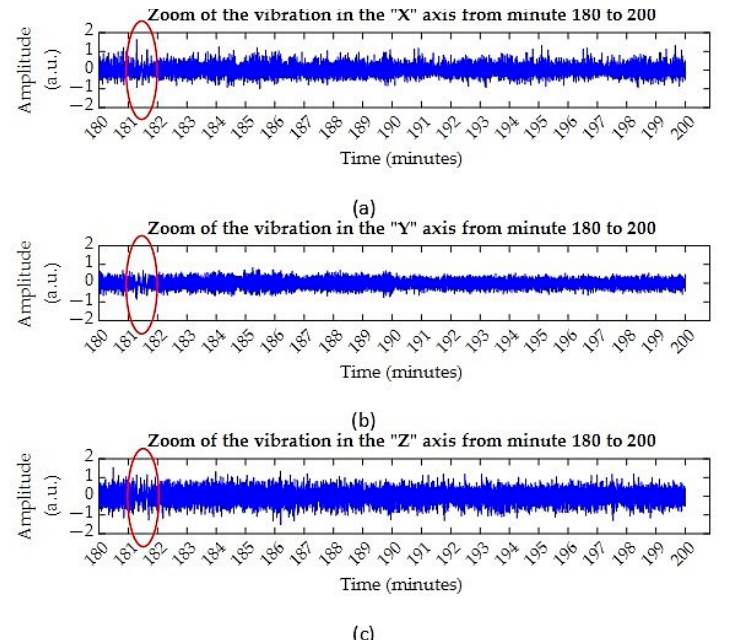
Figure 7. A disturbance in the system is shown zooming in from 180 to 200 min according to the axis: ( a ) “X” axis; ( b ) “Y” axis; ( c ) “Z” axis; a.u (arbitrary units). Figure 8 shows a zoom from minute 181.25 to 181.5, demonstrating the balance men- tioned at minute 181.27, where the “X” axis is the one that receives the highest positive amplitude, giving a peak of 1.645 a.u. (Figure 8a) while the “Y” axis has a negative peak of − 0.860 a.u. (Figure 8b), and the Z axis does not reach a maximum peak, but shows a positive amplitude, reaching 0.391 a.u. (Figure 8c). In Figure 8b, the “Z” axis does not reach a maximum peak, but shows a positive amplitude, reaching 0.391 a.u. (Figure 8c); on the other hand, in Figure 9 it shows a zoom from minute 188 to 188.25. The “Y” axis is the one that receives the highest positive amplitude at minute 188.22, having a peak of .696 a.u. (Figure 9a,) while the “Z” axis has a maximum negative peak of − 0.492 a.u. (Fig- ure 9b) and the “X” axis does not reach its maximum negative peak, with amplitude of − 0.379 a.u. (Figure 9c). In contrast, Figure 10 shows a zoom from minute 198 to minute 198.25, where the “Z” axis is the one that receives the highest positive amplitude at minute 198.23, giving a peak of 1.192 a.u. (Figure 10a), while the “Y” axis has a negative peak of − 0.040 a.u. (Figure 10b); interestingly, the “X” axis does not reach a maximum positive peak, reaching − 0.021 a.u. (Figure 10c).